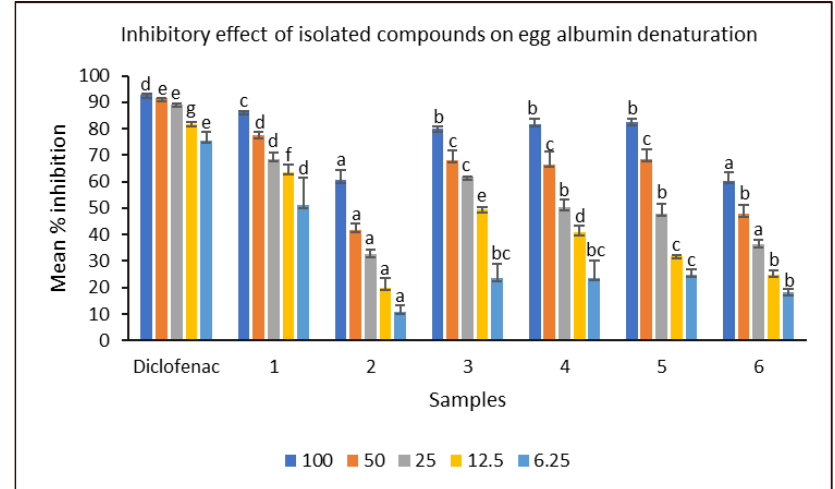
Figure 2. In vitro anti-inflammatory property of isolated compounds. Bioactivity expressed in terms of the ability of compounds to inhibit the denaturation of egg albumin; values in bar graph are expressed as mean ± SEM ( n = 3). Isolated compounds ( 1 – 6 ): stigmasterol ( 1 ), phenanthrene derivative ( 2 ), β -sitosterol ( 3 ), dodecanoic acid ( 4 ), ethyl nonadecanoate ( 5 ) and ethyl stearate ( 6 ); diclofenac (standard); compounds were analyzed across the various concentrations (100–6.25 µ g/mL) by one-way ANOVA; different alphabets on the same concentration (color) bar are considered significant at p < 0.05. Table 6. Anti-elastase Activity of Isolated Compounds Isolated from Cyperus sexangularis Leaf. Isolated